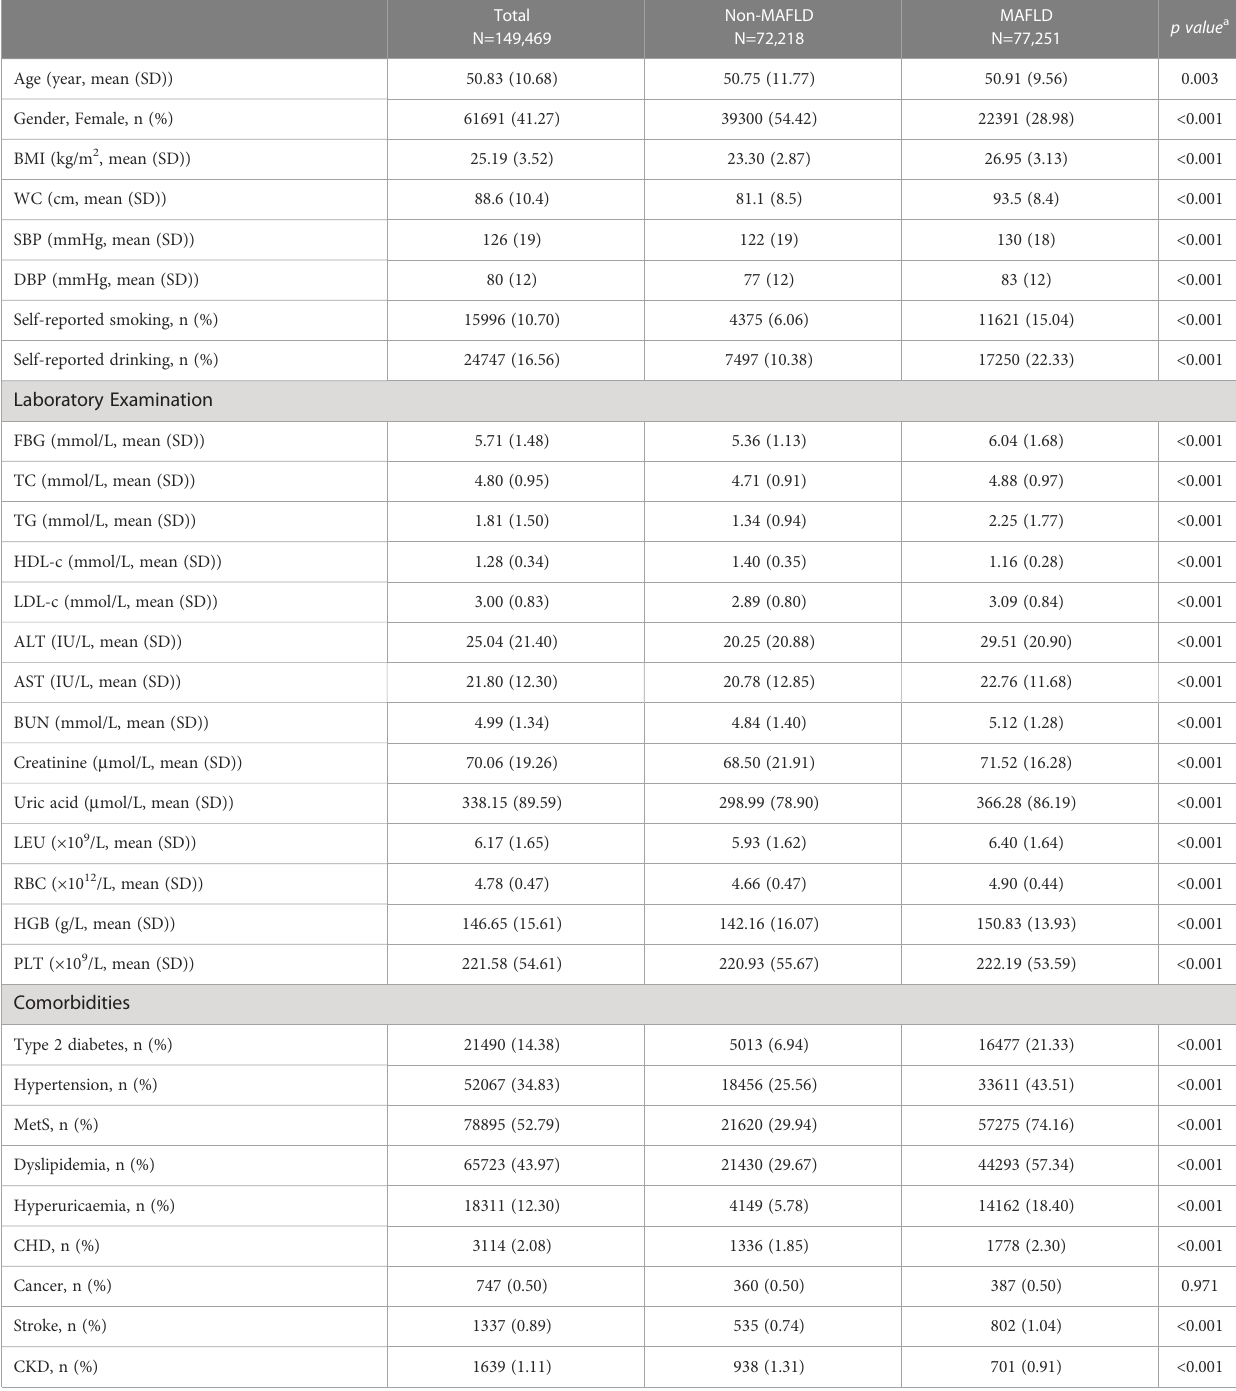
TABLE 1 Baseline characteristics for the cross-sectional